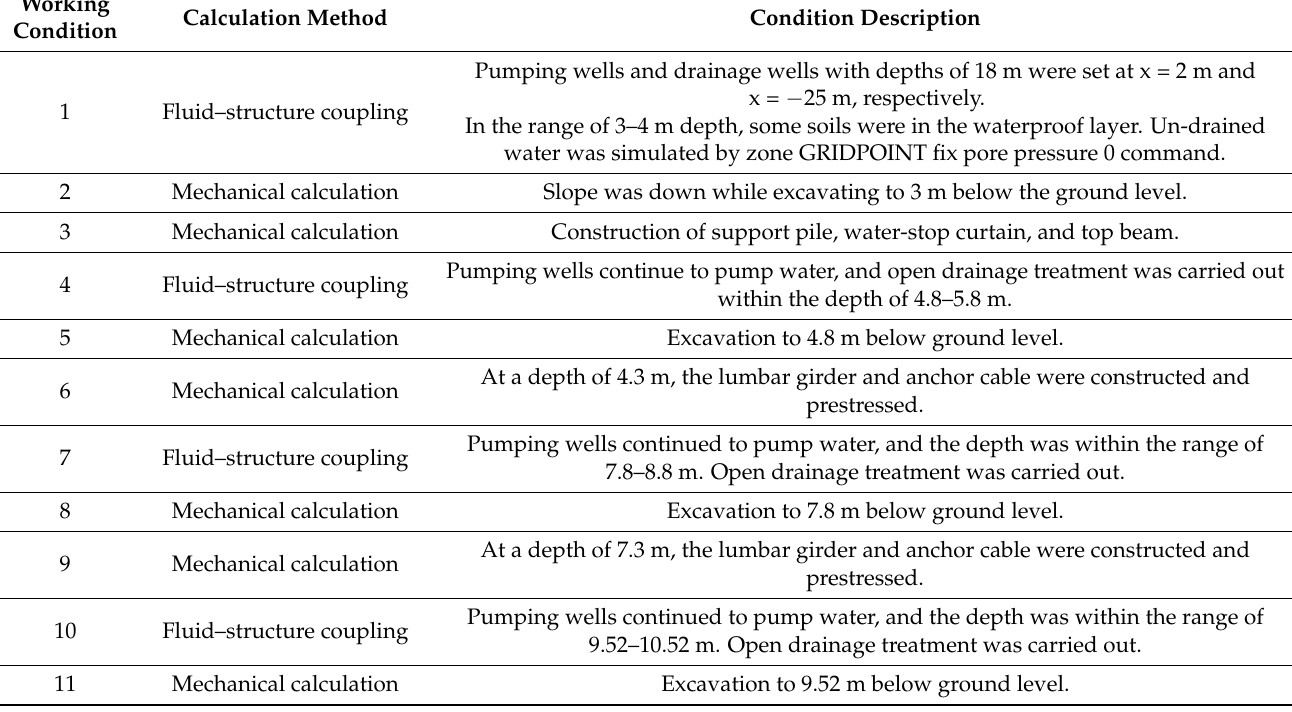
Table 5. Foundation pit working